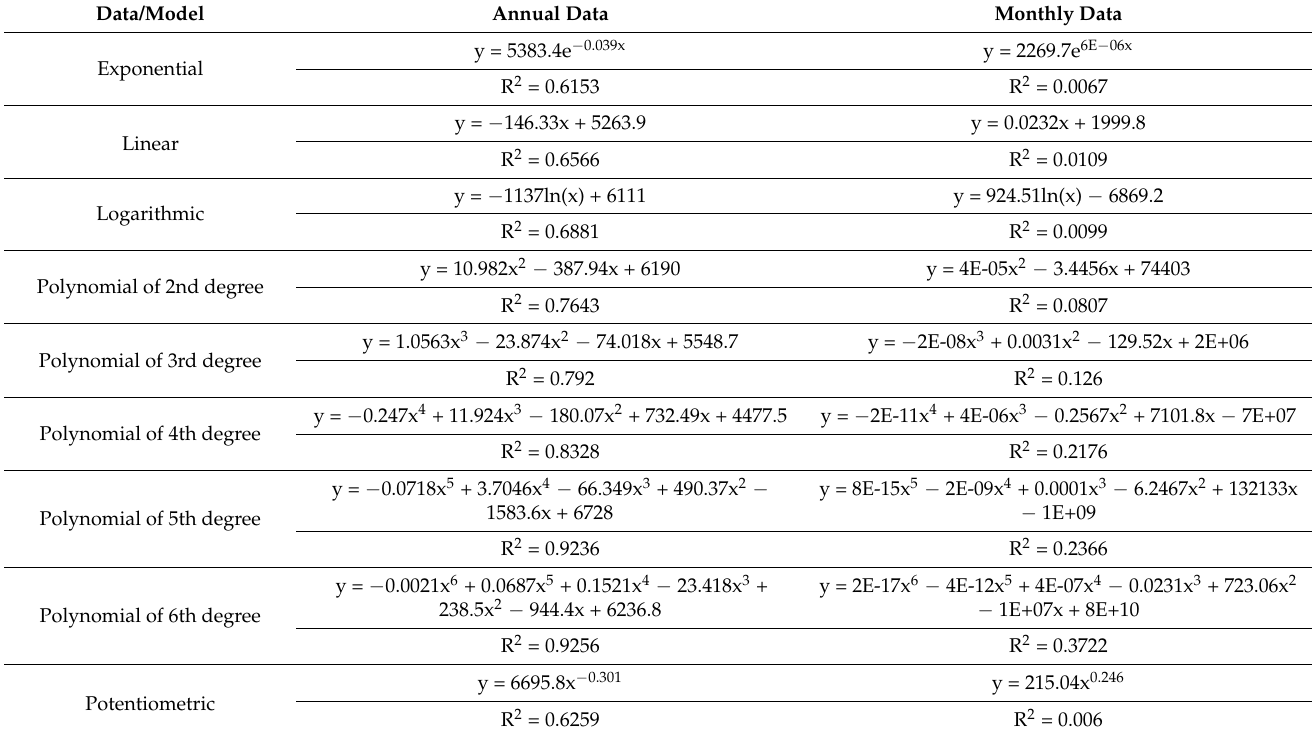
Table A15. Trend models for Greater Poland